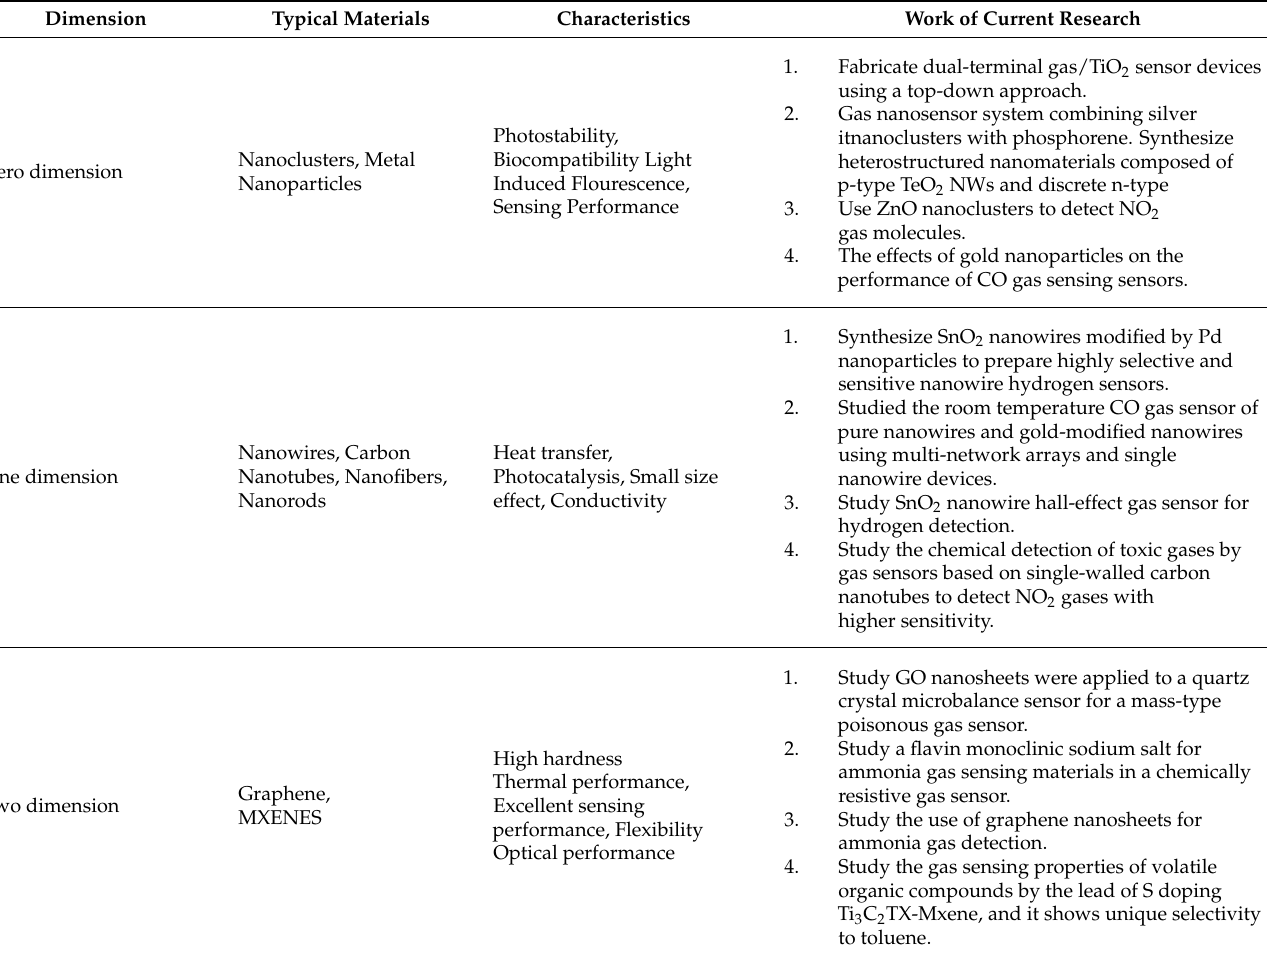
Table 1. A brief summary of nanomaterials with different